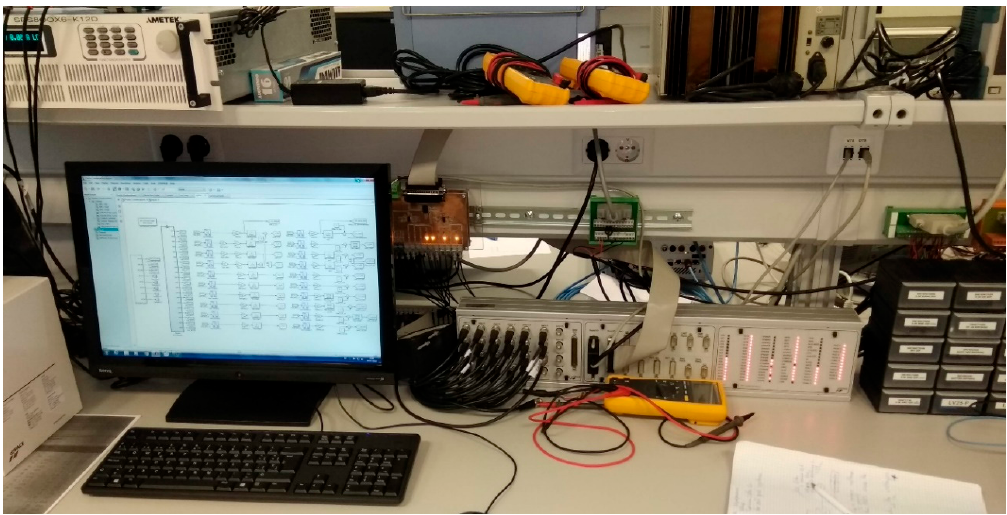
Figure 20. dSPACE1103 platform (centre) and programmable DC power supply AMREL (top left).